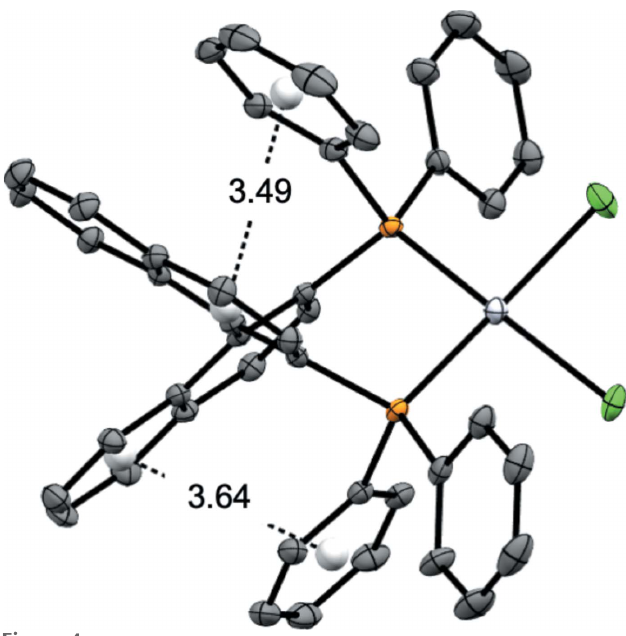
Figure 4 View showing the close intramolecular contacts between the naphthyl and phenyl rings in the title compound.